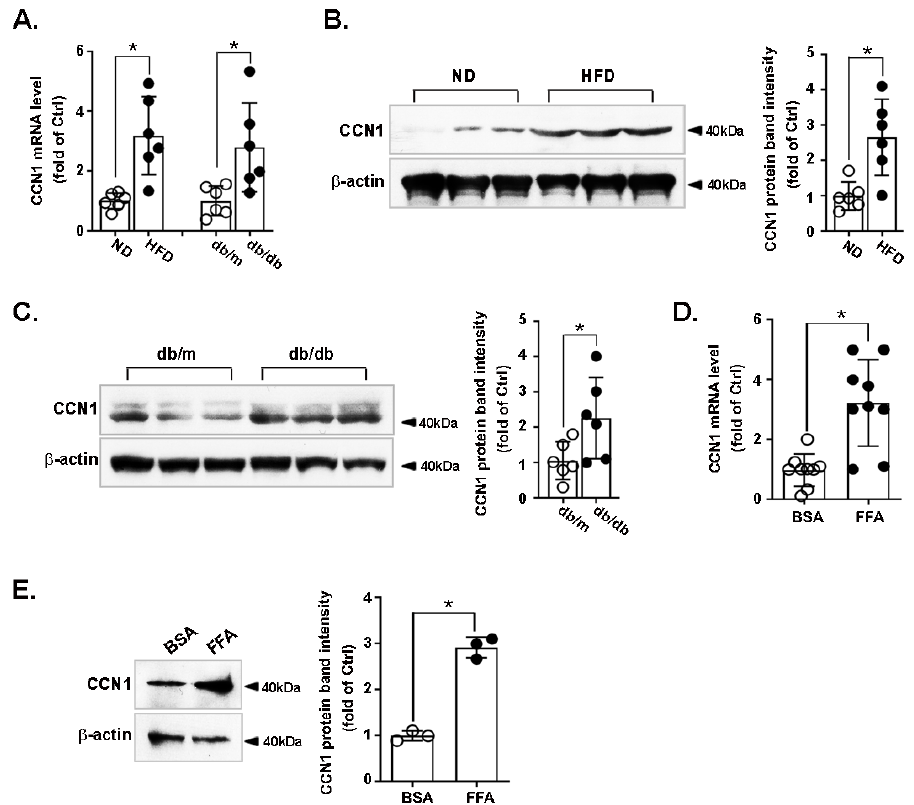
Figure 1. Expression of CCN1 in the livers of obese mice and in FFA-treated hepatocytes. Mice were fed with normal (ND) or high fat diet (HFD) for 16 weeks (n = 6 in each group) or were bred to be db/m or db/db mice (8 weeks old, n = 6 in each group). The mice were sacrificed at 16 weeks old or 8 weeks old, respectively. The livers were immediately dissected and subjected to quick-freezing in liquid nitrogen. The mRNA ( A ) and protein levels (( B ): ND and HFD mice; ( C ): db/m and db/db mice) of CCN1 were measured by RT-qPCR and immunoblotting. LO2 hepatocytes were treated with bovine serum albumin (BSA) or free fatty acid (FFA, 1 mM) for 24 h. The CCN1 levels in cell lysates were analyzed using ( D ) RT-qPCR and ( E ) immunoblotting. The RT-qPCR data shown are from three independent experiments performed in triplicate. The immunoblots shown are representative of five independent experiments. Quantifications of band intensity were normalized to β -actin. * p < 0.05.